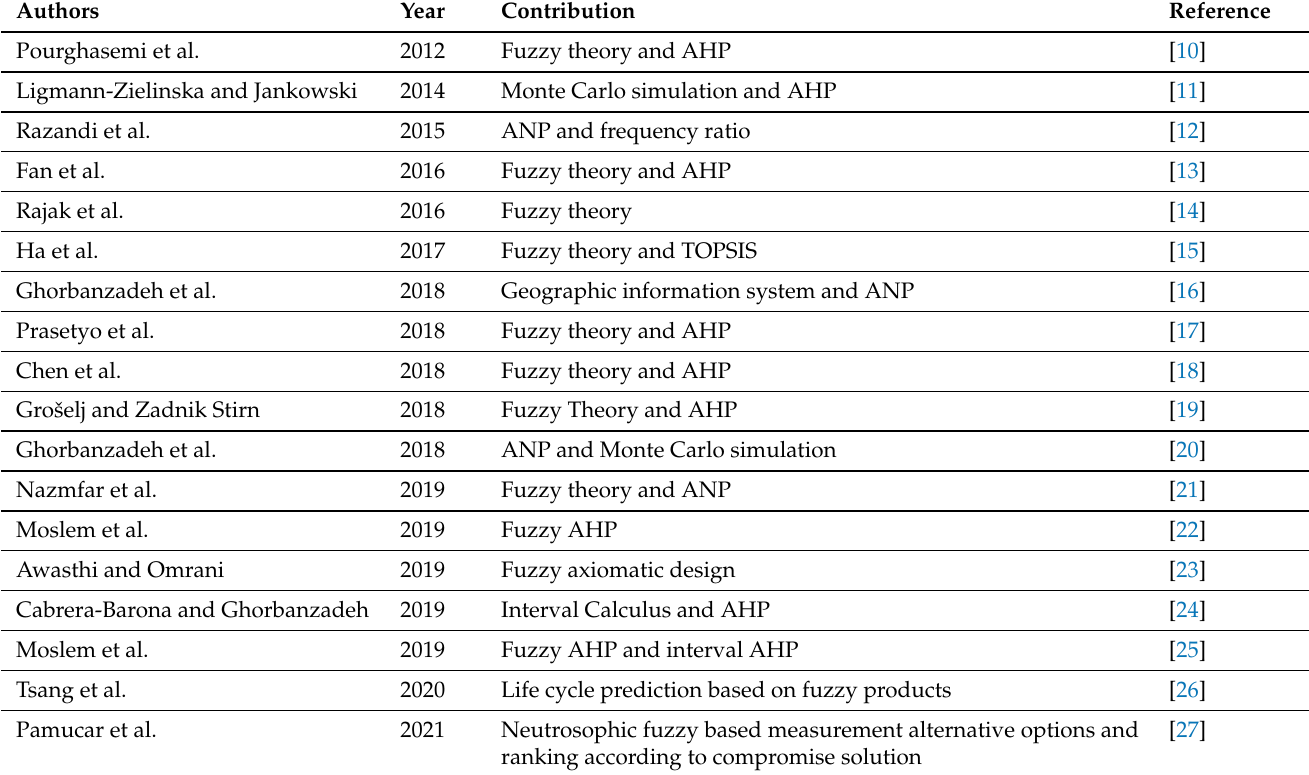
Table 1. An outline of the literature